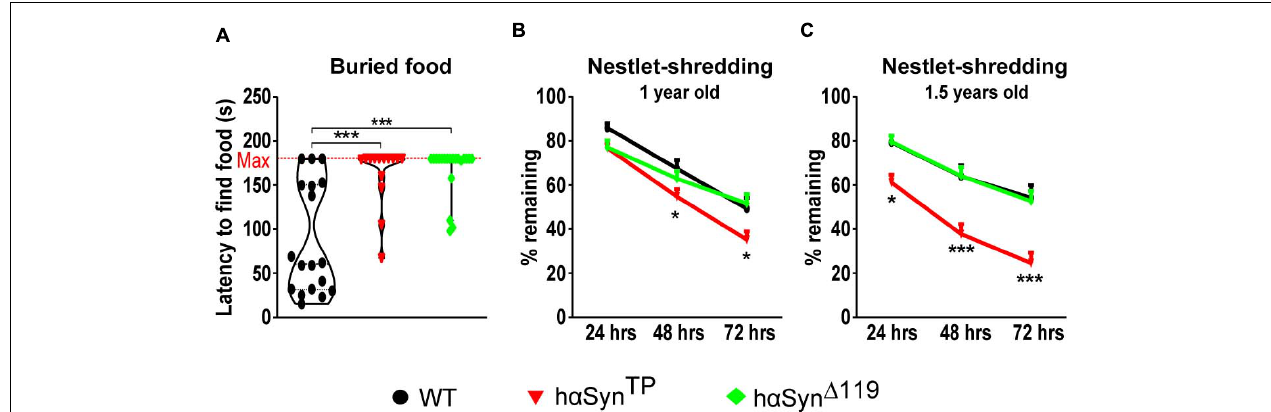
FIGURE 6 | Olfactory impairment and abnormal nestlet-shredding behavior in h α Syn TP and h α Syn (cid:49) 119 mice. (A) Buried food test showed 1.5 years old h α Syn TP and h α Syn (cid:49) 119 mice were mostly unable to find the buried cereal ball. Group comparisons using 1-way ANOVA with Tukey’s multiple comparisons test. (B,C) Nestlet-shredding for 1 and 1.5 years old WT, h α Syn TP , and h α Syn (cid:49) 119 mice was compared. Group comparisons using 2-way ANOVA with Bonferroni’s multiple comparisons test. Values in (A–C) represent mean ± SEM. * p < 0.05, and *** p <